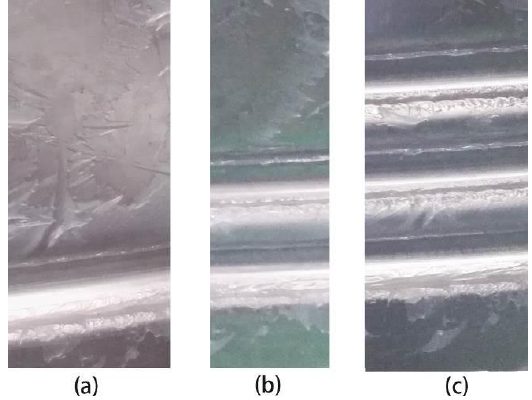
Figure 8. Results following each spinning step. ( a ) First step; ( b ) second step; ( c ) third step.